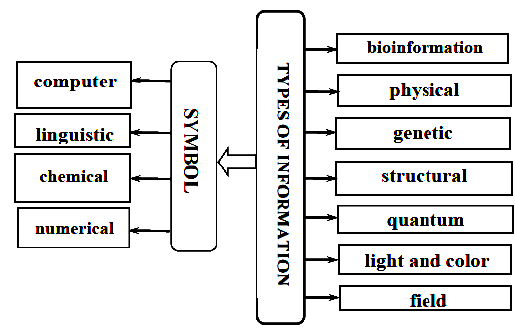
Fig.2. The scheme of the types of the information